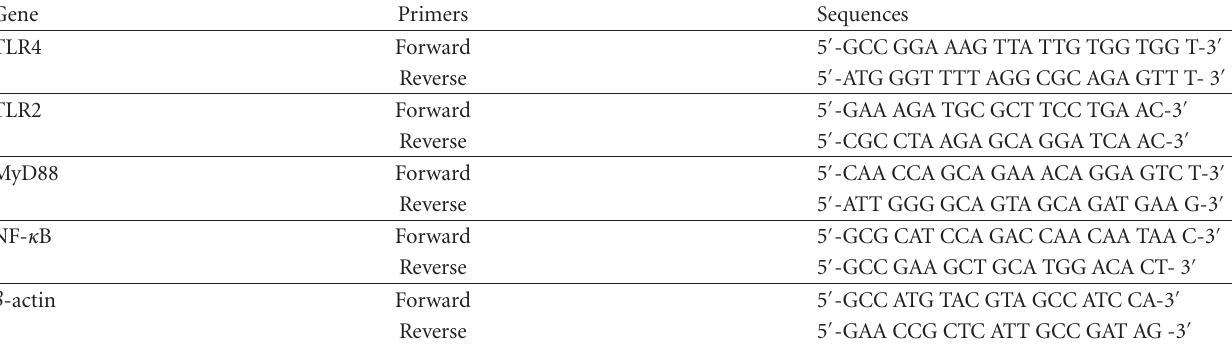
Table 1: Summary of the RT-PCR Primers sequences.